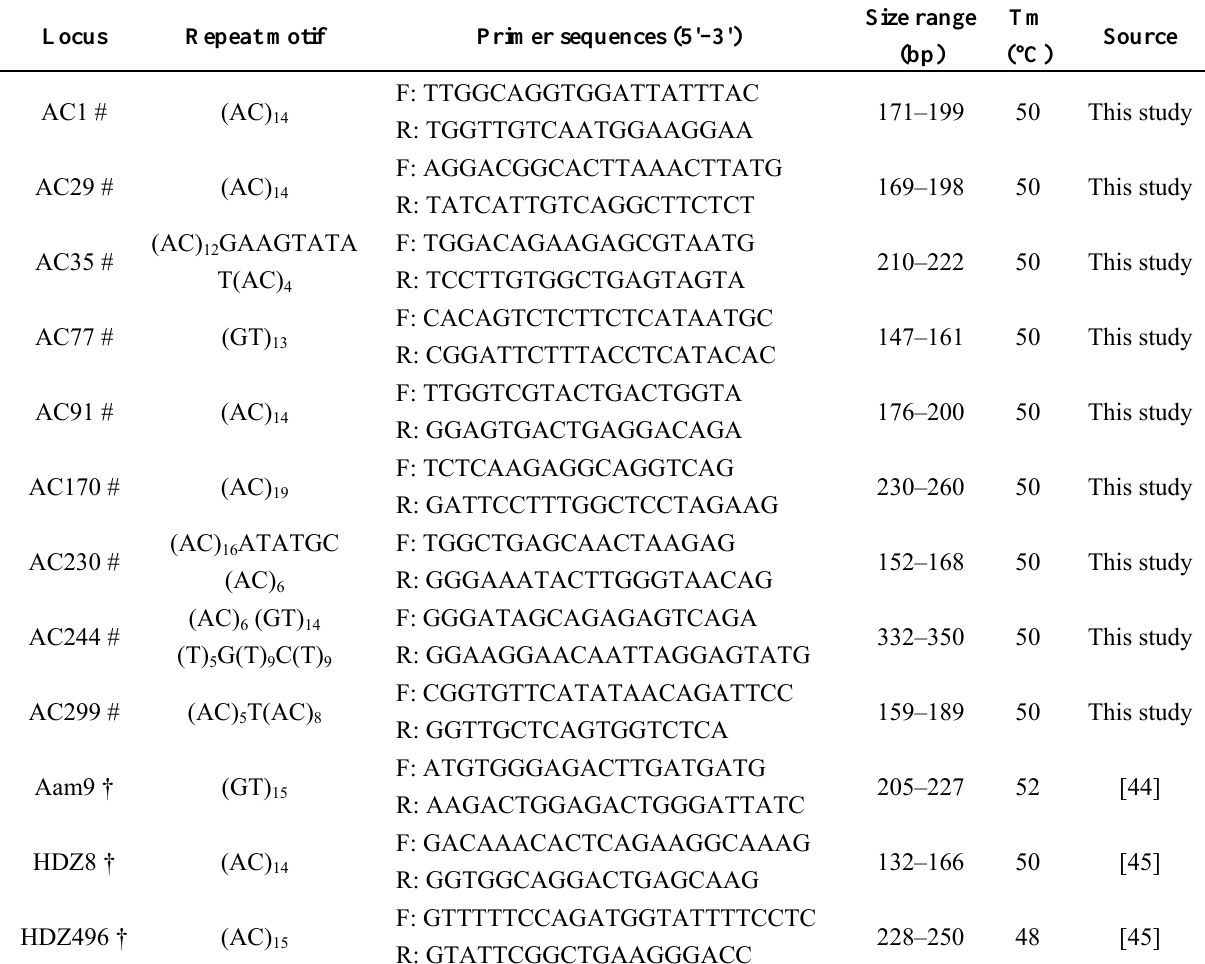
Table 1. Twenty microsatellite loci isolated for three species of Procapra